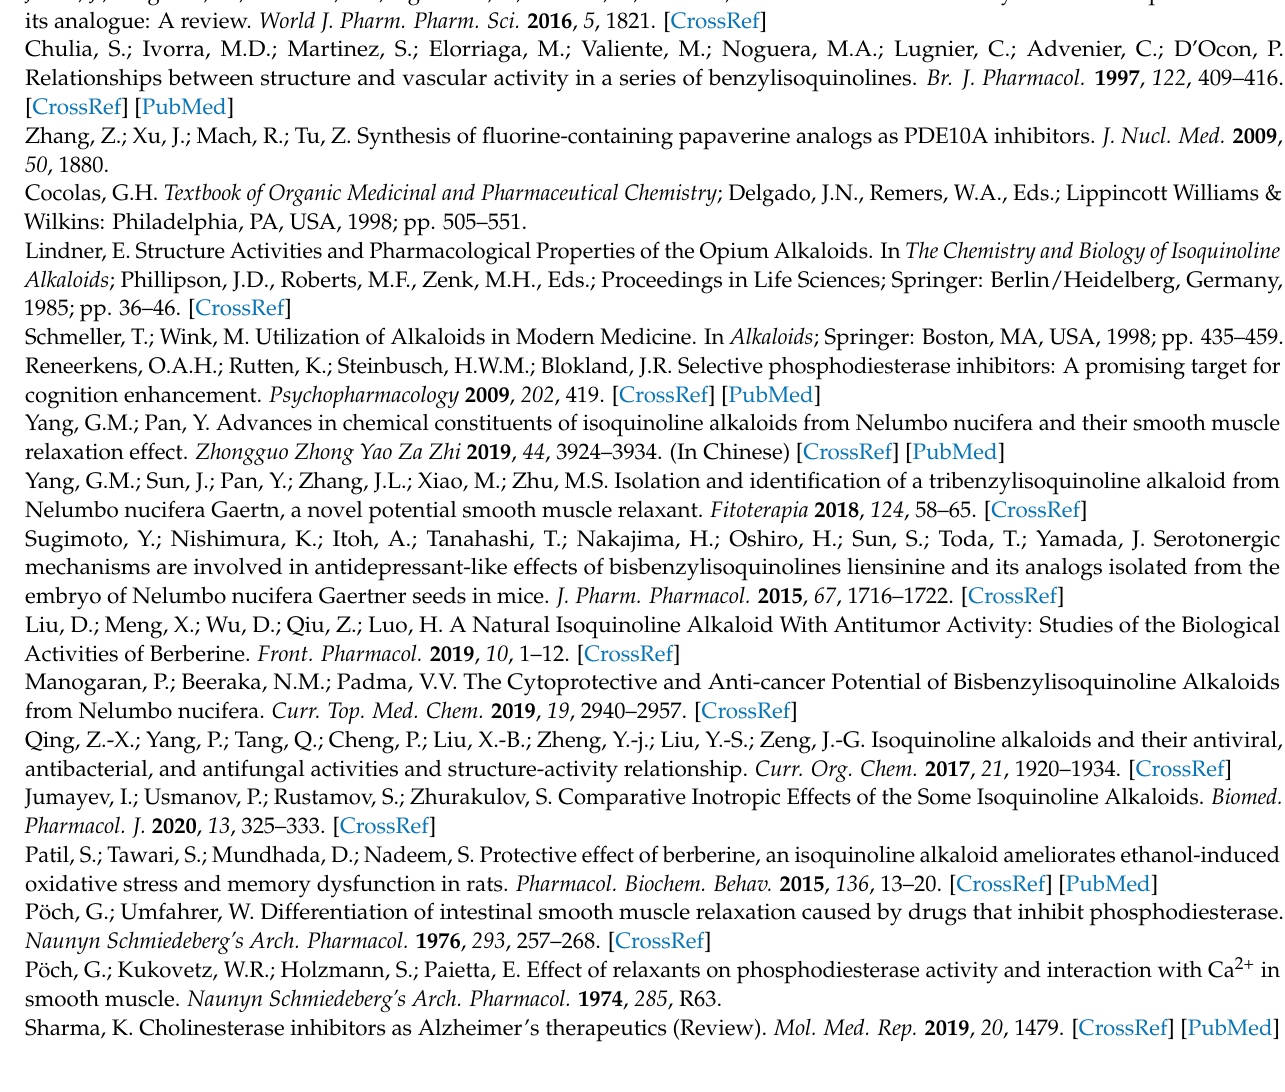
compound 4d , page 15 Figure S15: 1 H-NMR spectrum of compound 4e , Figure S16: 13 C-NMR spectrum of compound 4e , Figure S17: IR spectrum of compound 4e